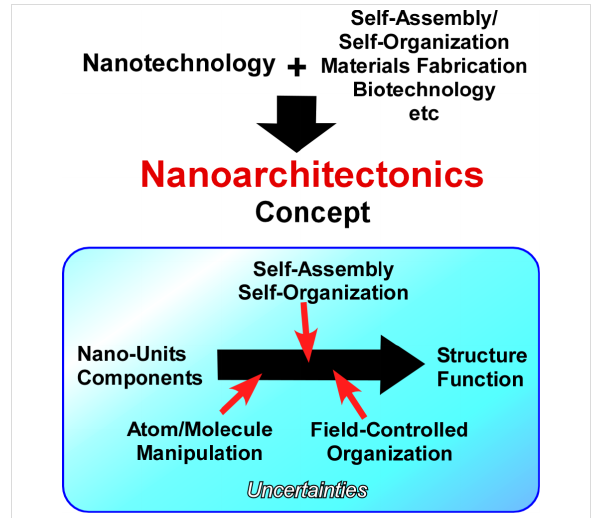
Figure 2: Outline of nanoarchitectonics strategies to obtain structures and functions through the manipulation of atoms and molecules, self- assembly and self-organization, and field-controlled